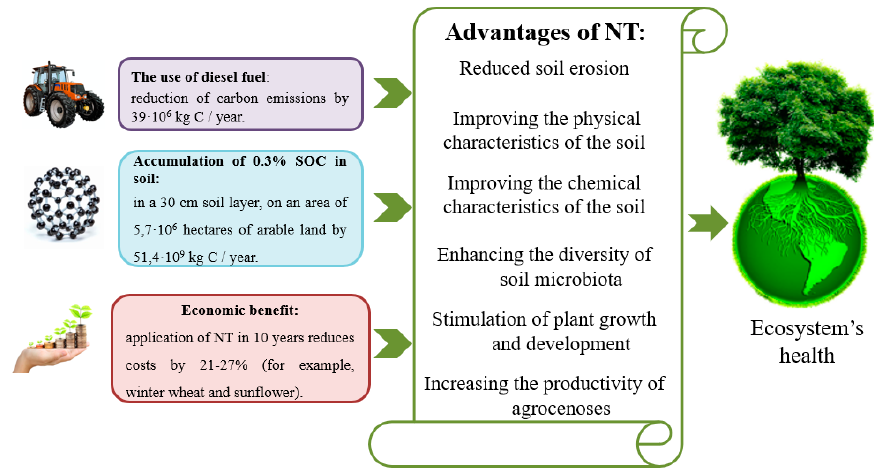
Figure 5. Environmental Consequences of NT technologies in comparison to CT.